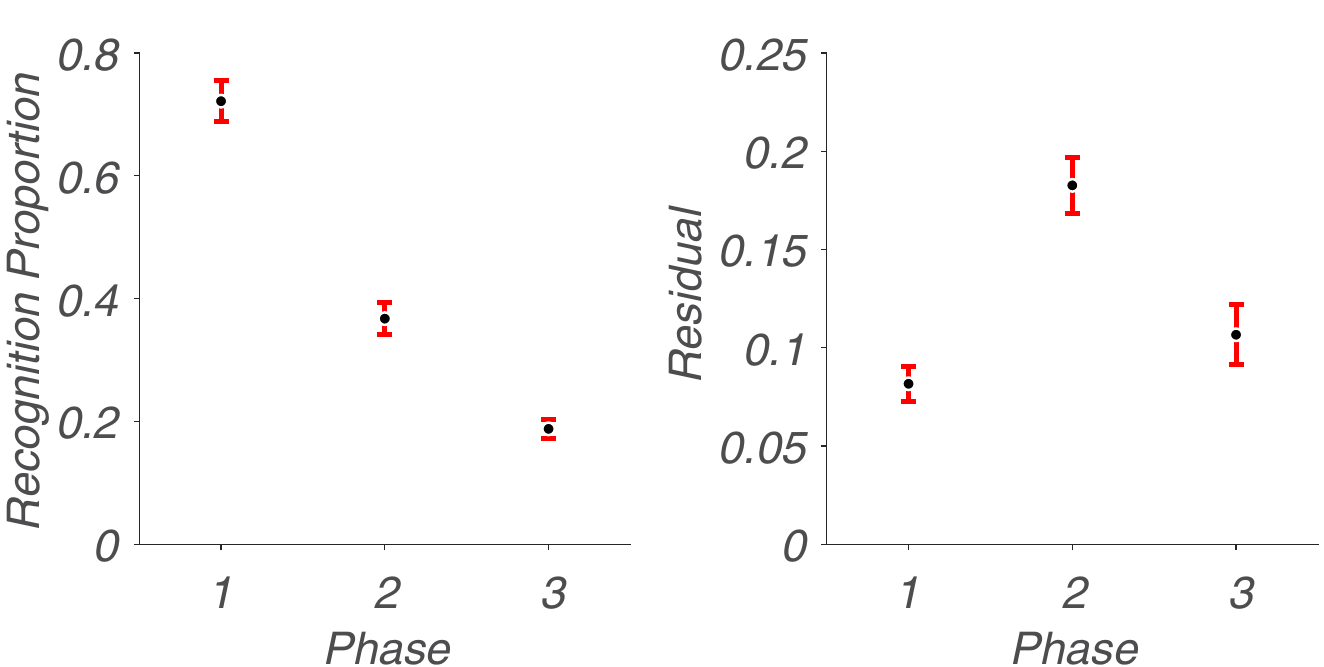
Fig 3. Quantifying average song recognition proportions and their variability over the three phases. Left panel: Black dots represent the mean recognition rate for a given phase. Red bars represent the standard error of the mean. Right panel: Black dots represent the average residual—the distance between individual songs to the corresponding point on the convolved average (red curve) from Fig 1, for a given phase. Red bars represent the standard error of the mean.